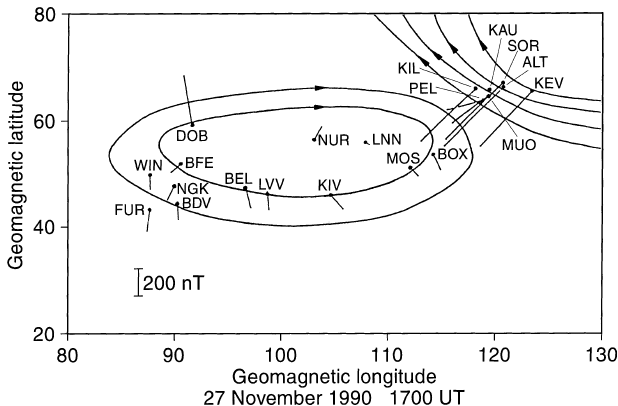
Fig. 11. Horizontal magnetic disturbance vectors and the equivalent ionospheric current system, respectively, for 1700UT on 27 November